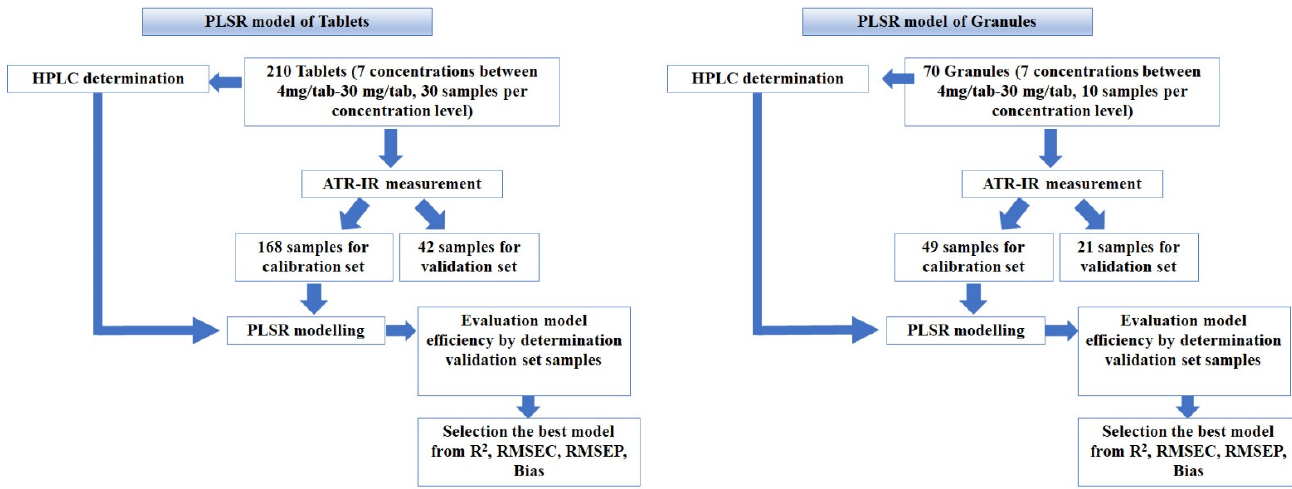
Figure 8. Schematic diagram for PLSR models construction for tablets and granules. The PLSR models for the granules were performed in the same manner as the tablets. Seventy elements of AIR-IR spectral data were imported into Unscrambler to construct various PLSR models from original and pretreated data. Forty-nine samples (seven strengths with seven samples from each strength) were randomly selected as calibration samples. The remaining 21 samples were used as validation samples. Various PLSR models were performed from original and pretreated data with respect to reference values from the HPLC method. A suitable model was selected from the optimal parameters, i.e., R 2 of the calibration model, R 2 of cross-validation, root-mean-square error of prediction (RMSEP), bias, and the prediction ability of validation samples. The calibration and validation samples’ composition for CPM tablets and granules are presented in Table 4.